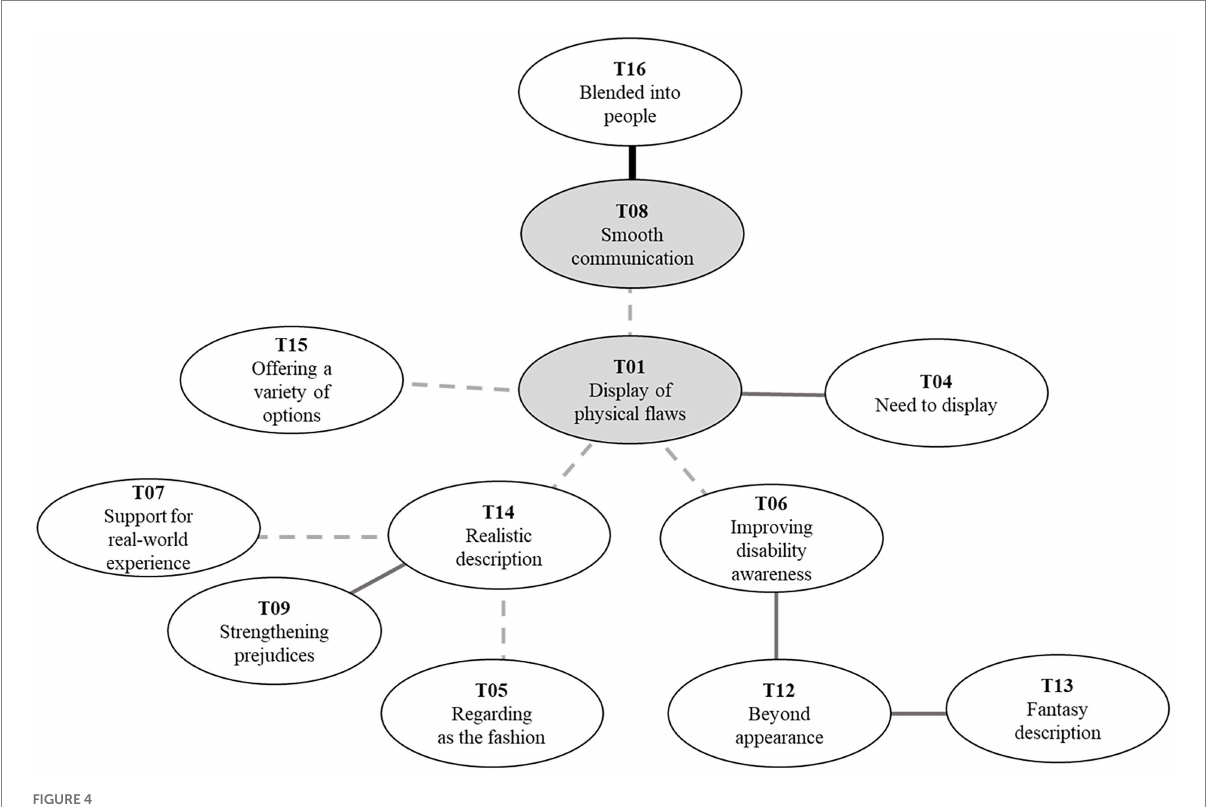
FIGURE 4 Positive perspective on avatar-based disability representations.